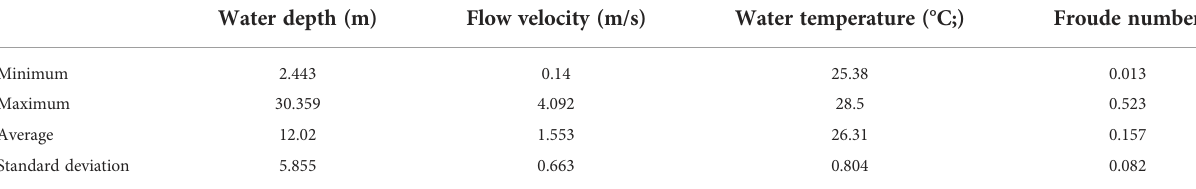
TABLE 2 Distribution of measured